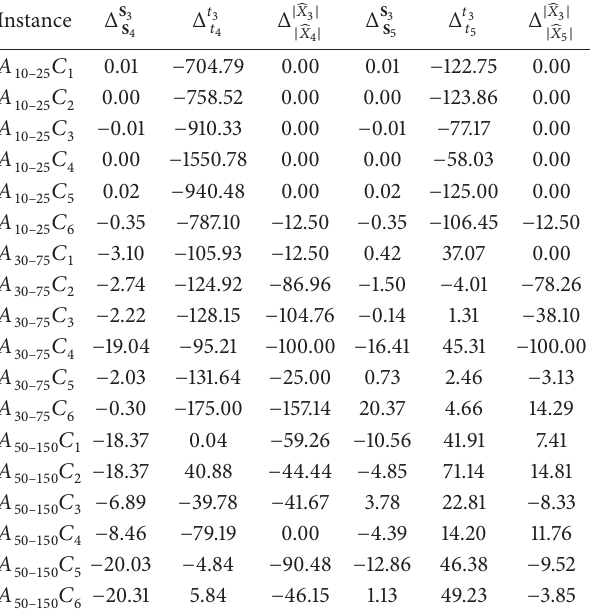
Table 9: Comparison among our BOCA with normative knowledge and NSGA-II and